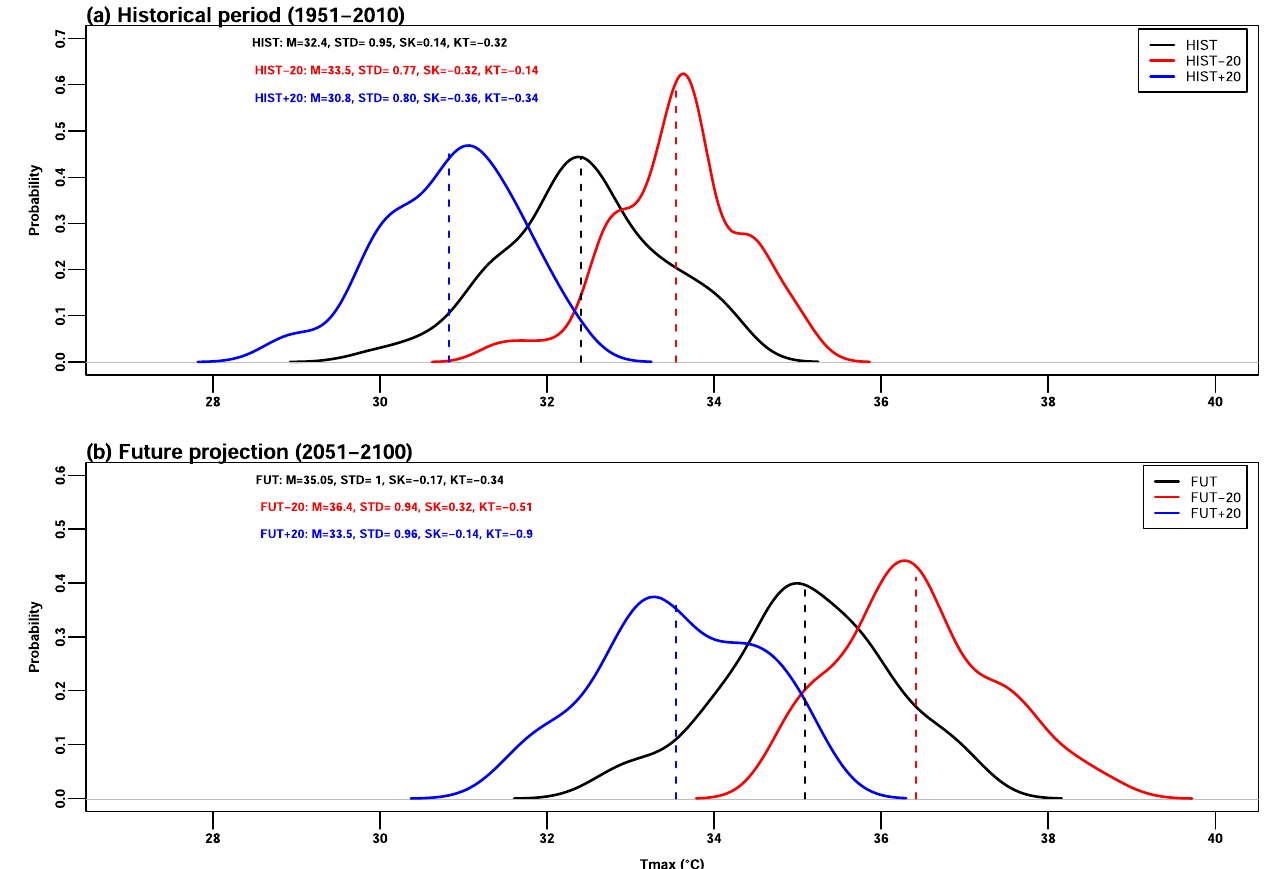
Fig. 9 Probability density function with fi rst four moments of dispersion. Probability density function of T max over the NCI for control (black line), dry SM (red line) and wet SM (blue line) experiments during the ( a ) historical period (1951 – 2010) and ( b ) future projection (2051 – 2100). The vertical dotted line in each PDF indicates corresponding mean value. The values of the fi rst four moments of dispersion (M mean, STD standard deviation, SK skewness, KT kurtosis) are given at the top left corners in